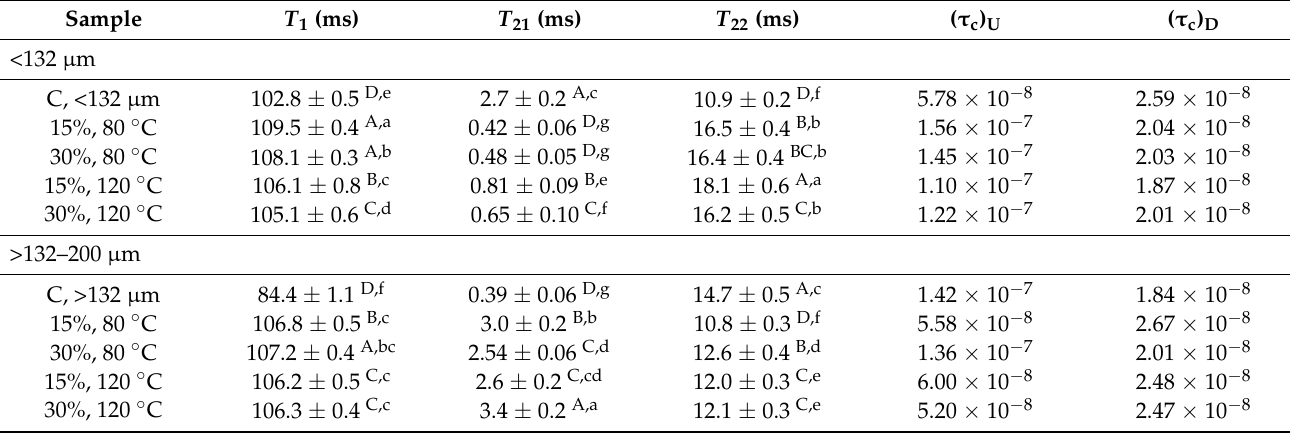
Table 5. LF NMR relaxometry